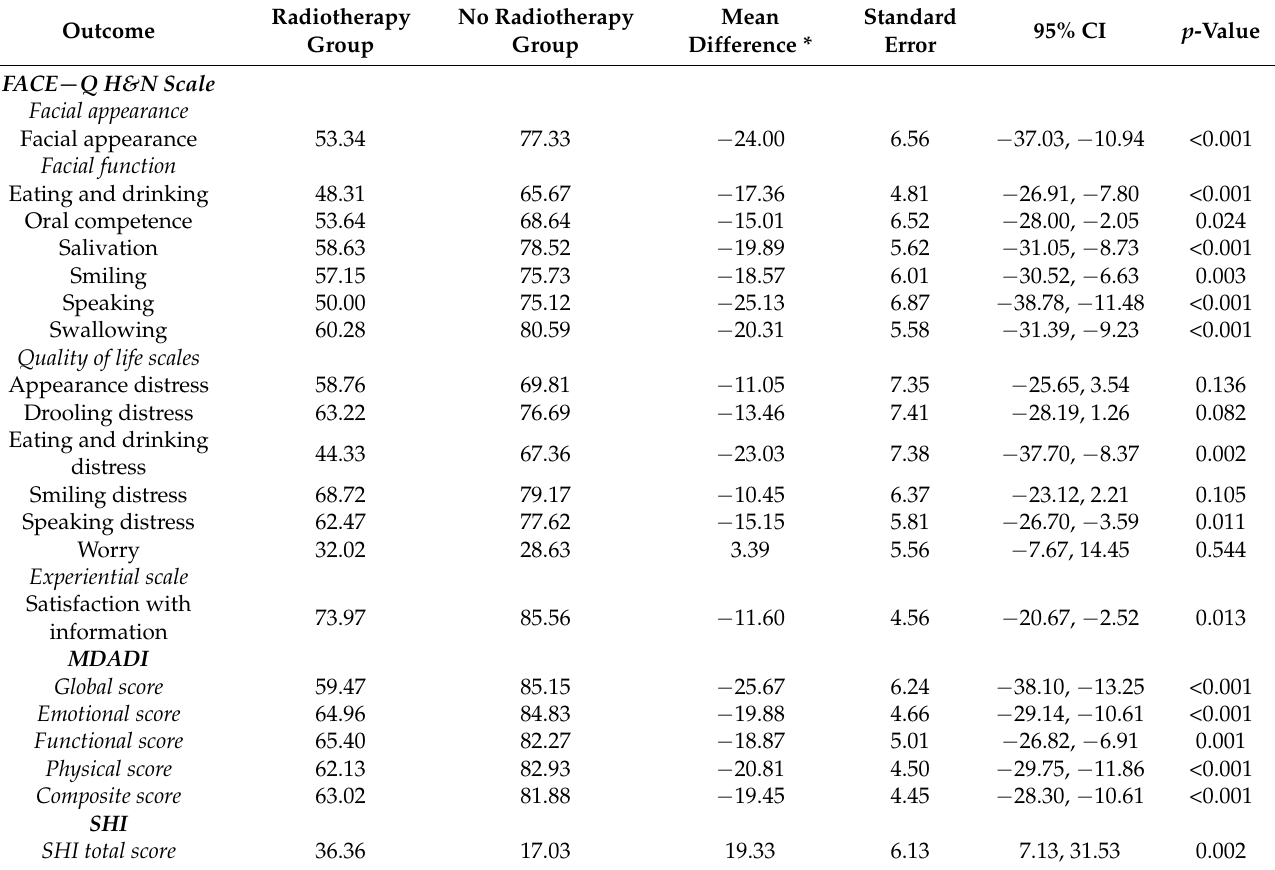
Table 3. Mean scores on the FACE-Q H&N, MDADI, and SHI based on whether patients did or did not have a history of radiotherapy. Higher scores indicate better outcomes, except for the FACE-Q H&N Worry Scale and for the SHI Total Score, where higher scores indicate greater worry and greater levels of speech-related problems,